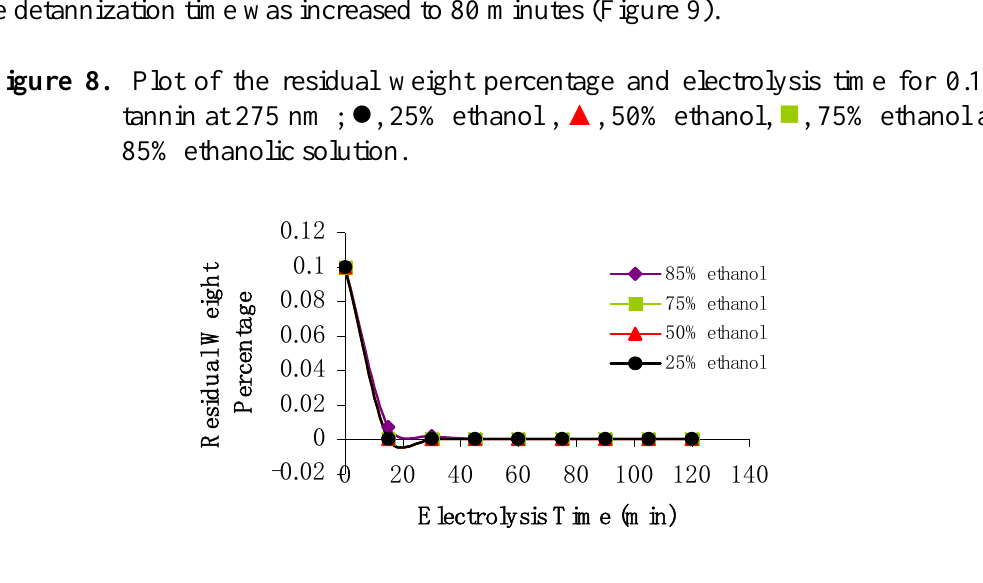
Figure 9. Plot of the residual weight percentage and electrolysis time for 1.0% w/v tannin at 275 nm; ▲ , 25% ethanol, (cid:132) , 50% ethanol, (cid:122) , 75% ethanol, and (cid:139) , 85% ethanolic